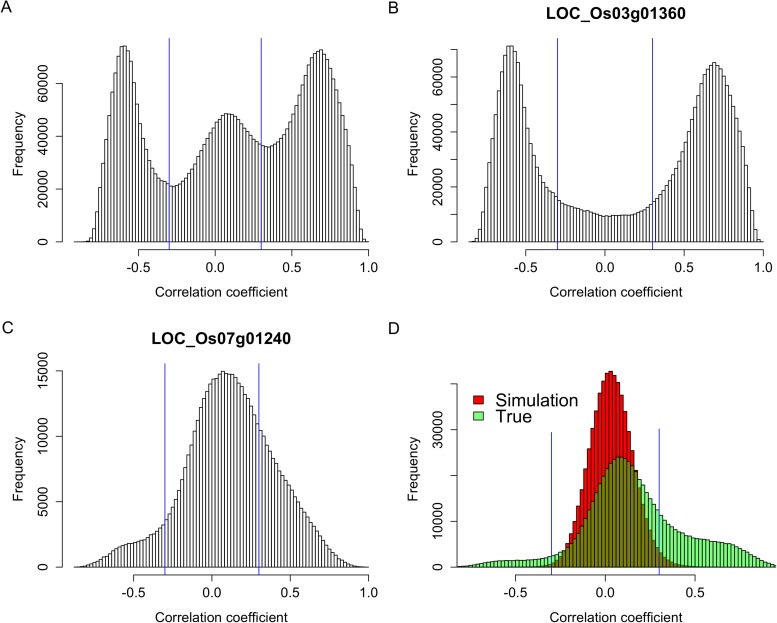
Expression correlations between s-traits originating from the same genes.(A) The distribution of expression correlations between s-traits originating from the same genes. (B) The distribution of expression correlations between s-traits originating from LOC_Os03g01360. (C) The distribution of expression correlations between s-traits originating from LOC_Os07g01240. (D) Comparison of the distribution of expression correlations for the simulation data and the true data excluding s-traits from LOC_Os03g01360 and LOC_Os07g01240.